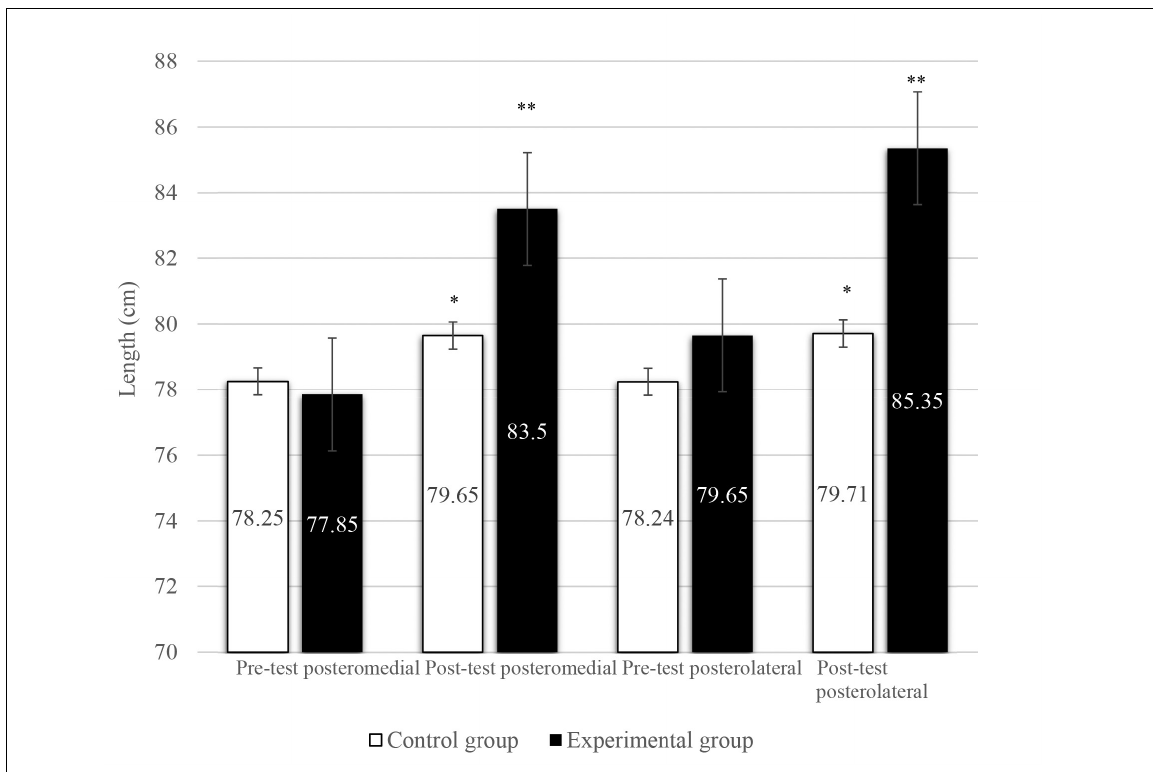
Figure 9. Dynamic balance left posterolateral and left posteromedial reach results of experimental and control